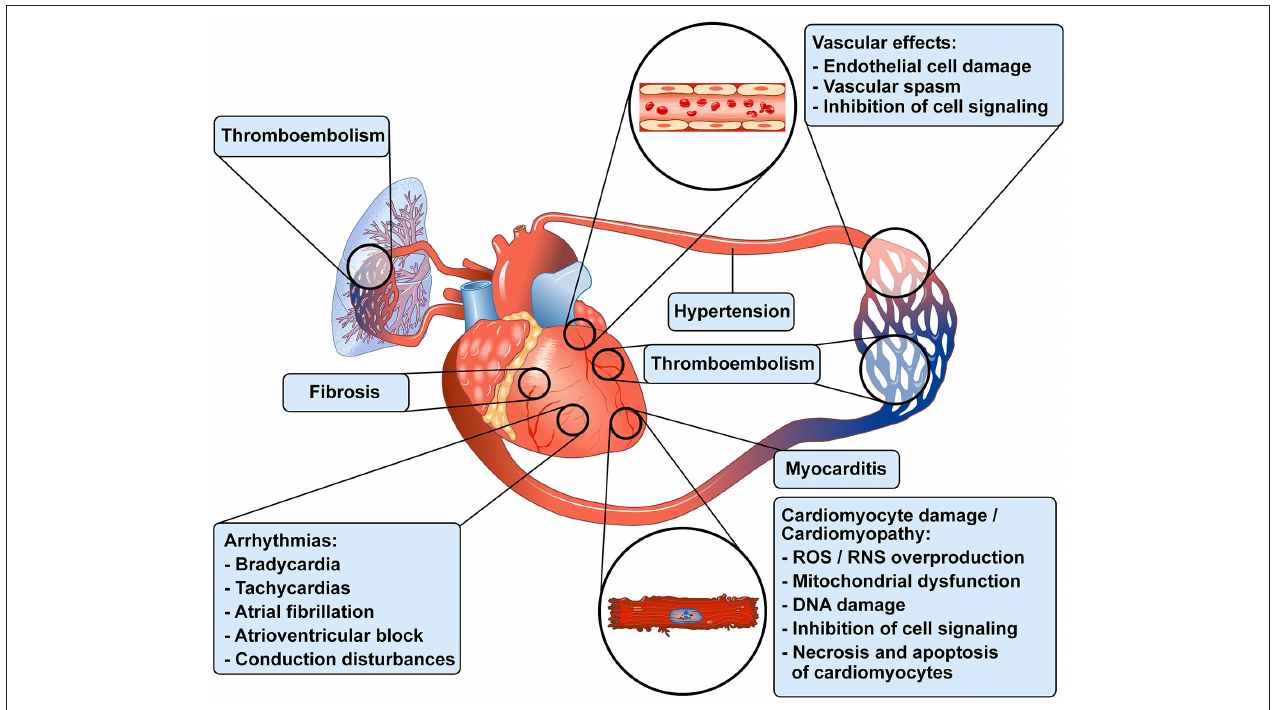
FIGURE 1 | Schematic representation of some of the cardiovascular toxicities associated with antineoplastic drugs in patients with cancer. Modified with permission from Albini et al. (2010).